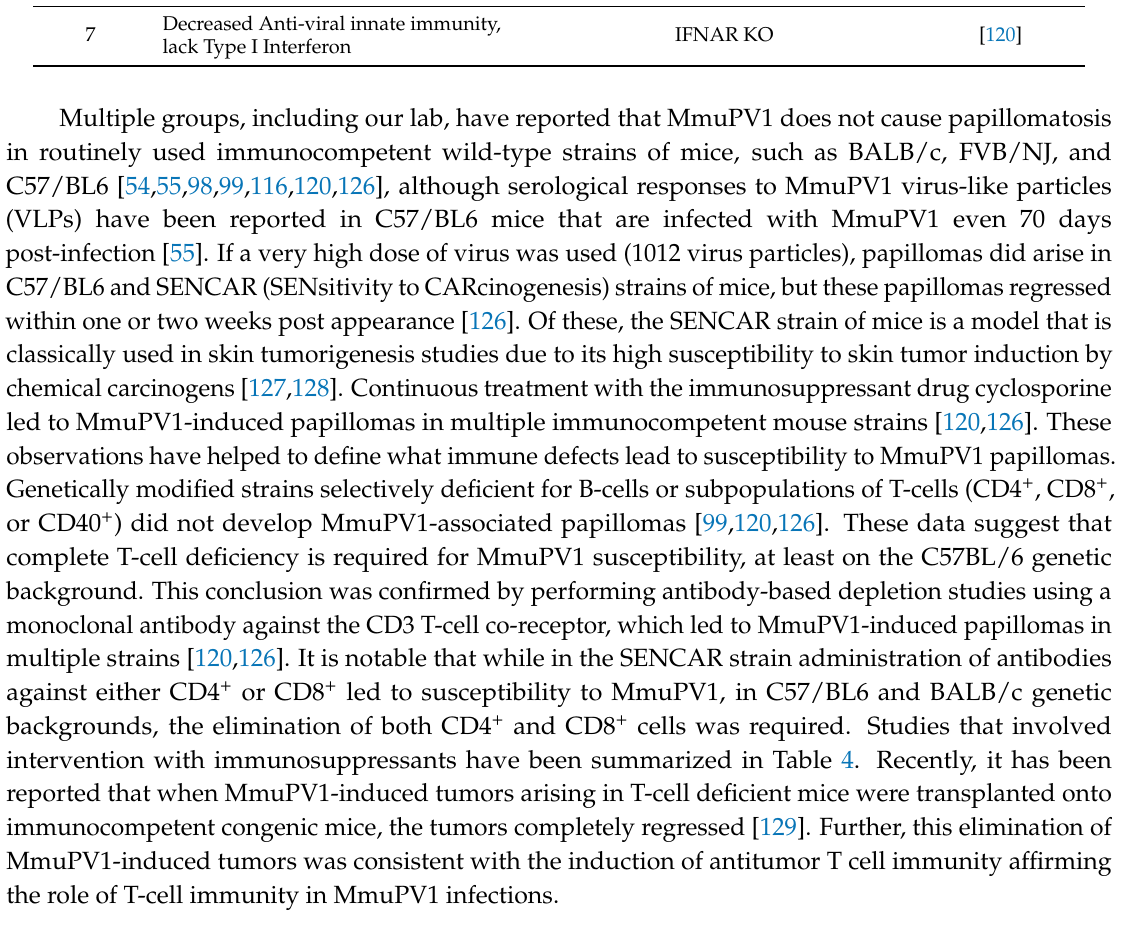
Table 4. List of immunocompetent mice found to be susceptible to MmuPV1 after treatment with